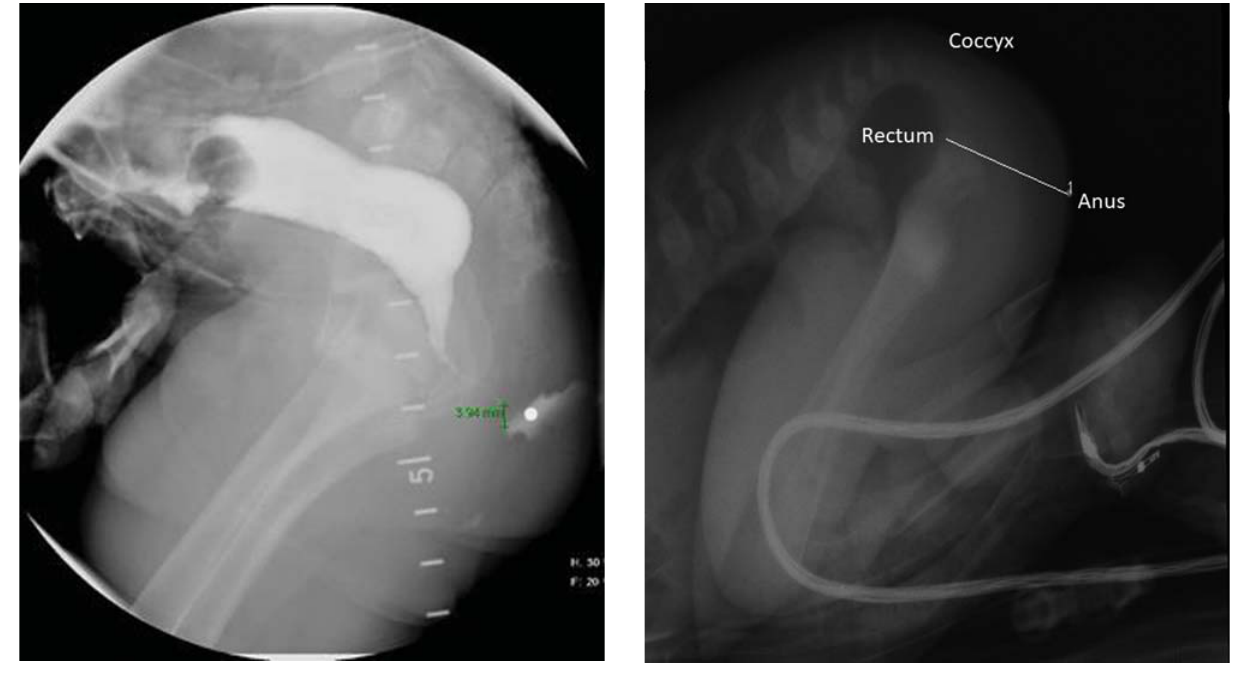
Fig. 2 Cross- fi re X-ray showing air column in rectum in relation to perineal skin and